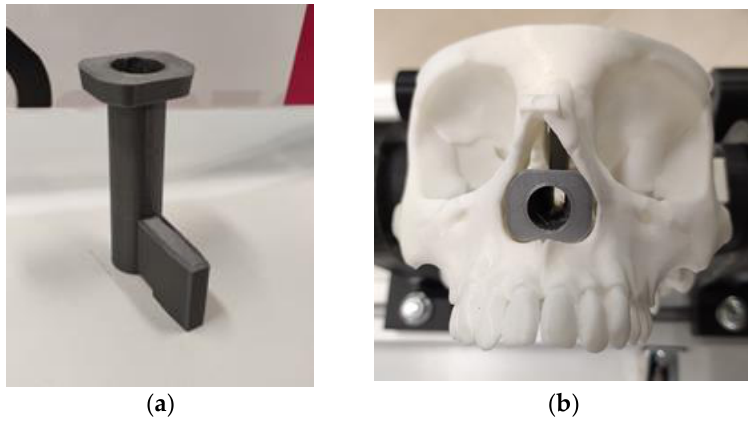
Figure 7. Piece manufactured to characterize the interior of the nasal cavity. ( a ) Piece made with 3D printing. ( b ) Piece placed on the skull model.